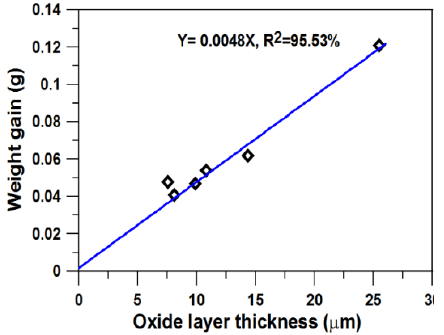
Figure 11. The relationship between the weight gain and the layer thickness of PEO coatings.